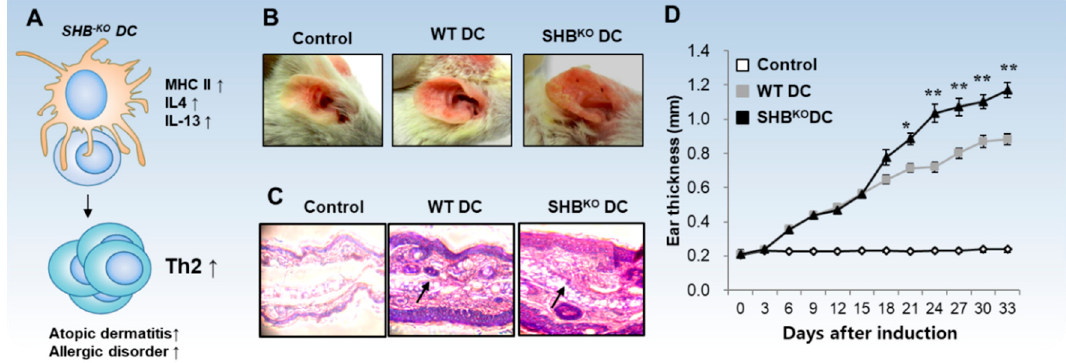
Figure 4. SHB-depleted DCs induce severe symptoms of AD in mice. ( A ) SHB KO DCs show typical cDC2 phenotypes, which induce Th2 inflammatory disorders. ( B ) In the mouse AD model, the mice subcutaneously injected with antigen-primed SHB-depleted DCs showed severe AD symptoms as compared with the control mice injected with SHB-normal DCs. ( C ) Histopathological analysis of AD after inoculation with normal and SHB KO DCs. Arrow indicates the infiltrated immune cells. ( D ) Graphical representation of ear thickness in mice after inoculation with normal and SHB KO DCs. Figure source Ahmed et al. (2017)